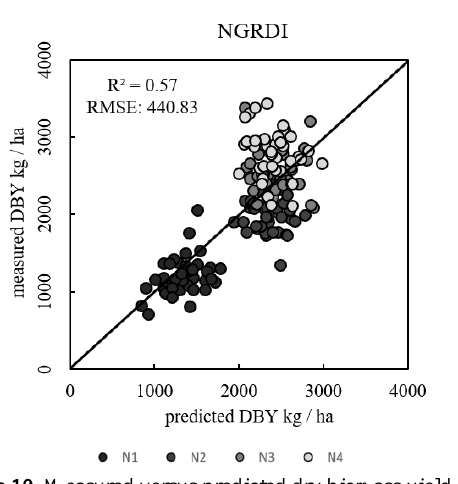
Figure 10. Measured versus predicted dry biomass yield [kg / ha] for